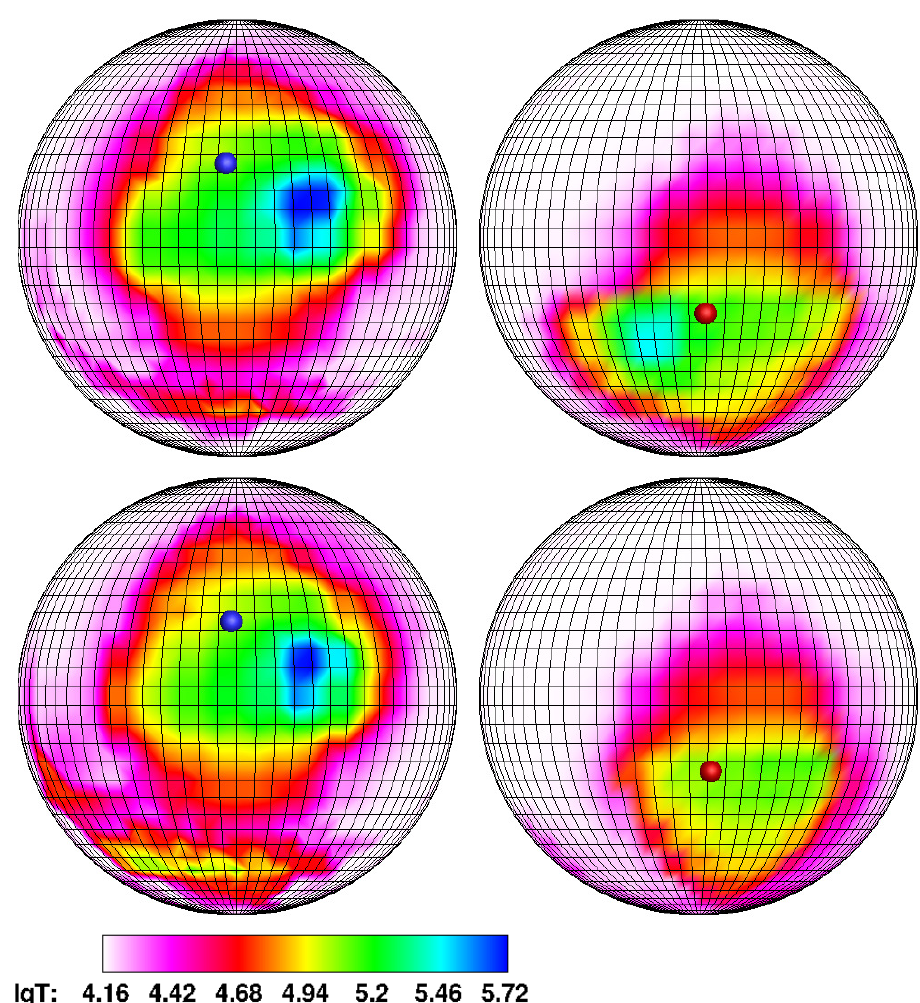
Figure 19. The same as in Figure 18, but for Phase 3 ( upper panel) and Phase 4 ( lower panel). At the first switching, due to the considerable length of the ballistic part of the trajec- tory and taking into account the fact that the axis of the dipole is perpendicular to the line connecting the donor and the accretor centers, the southern spot at the initial moment of time (Figure 18, upper panel) is located close to the pole, and its center has a deviation of about 5 ◦ . At the same time, at the formation moment of the arch of the matter (Figure 18, lower panel), the southern spot retains its position, having lost only a little in area, and the weakly pronounced northern spot is already 10 ◦ away from the pole at this stage. Then, at the phase of maximum convergence of hot spots (Figure 19, upper panel), the angles of their deviation are 15 ◦ for the south and 20 ◦ for the north. Note here that the size of the southern spot still does not change, while the northern spot is slightly elongated along the latitude of the star. Finally, after the switching is completed (Figure 19, lower panel), the accretion of matter from the common envelope occurs in the vicinity of the south pole, and the northern hot spot has reduced its size by two times in longitude and has retained the magnitude of deviation from the